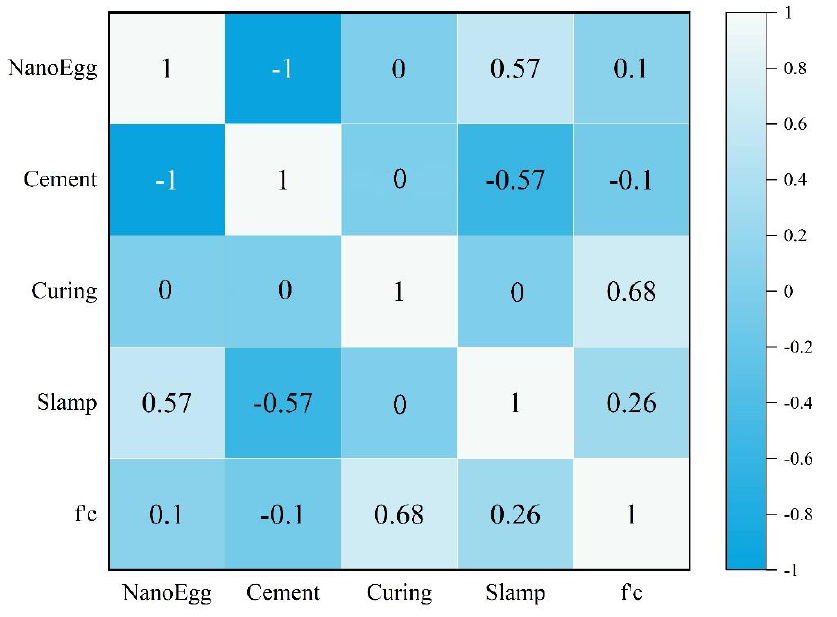
Figure 5. Correlation matrix for the input and output variables.